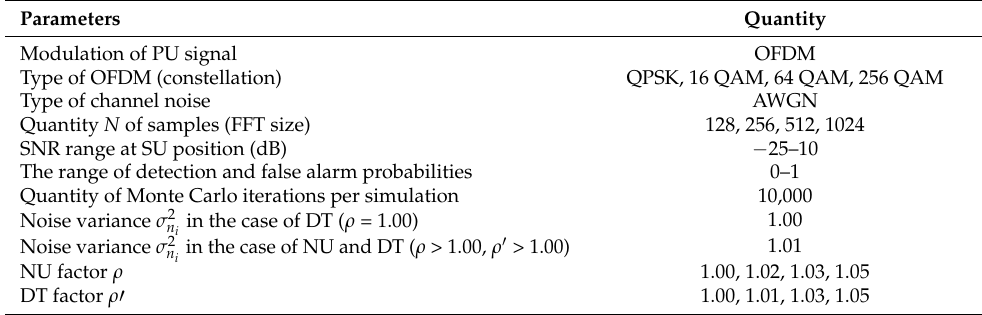
Table 3. Parameters used in